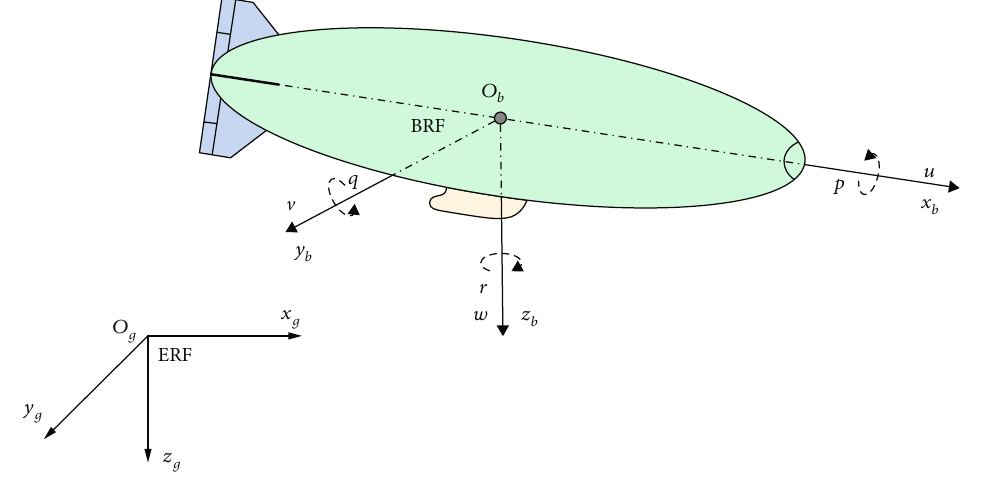
Figure 1: Structure of the stratospheric satellite.